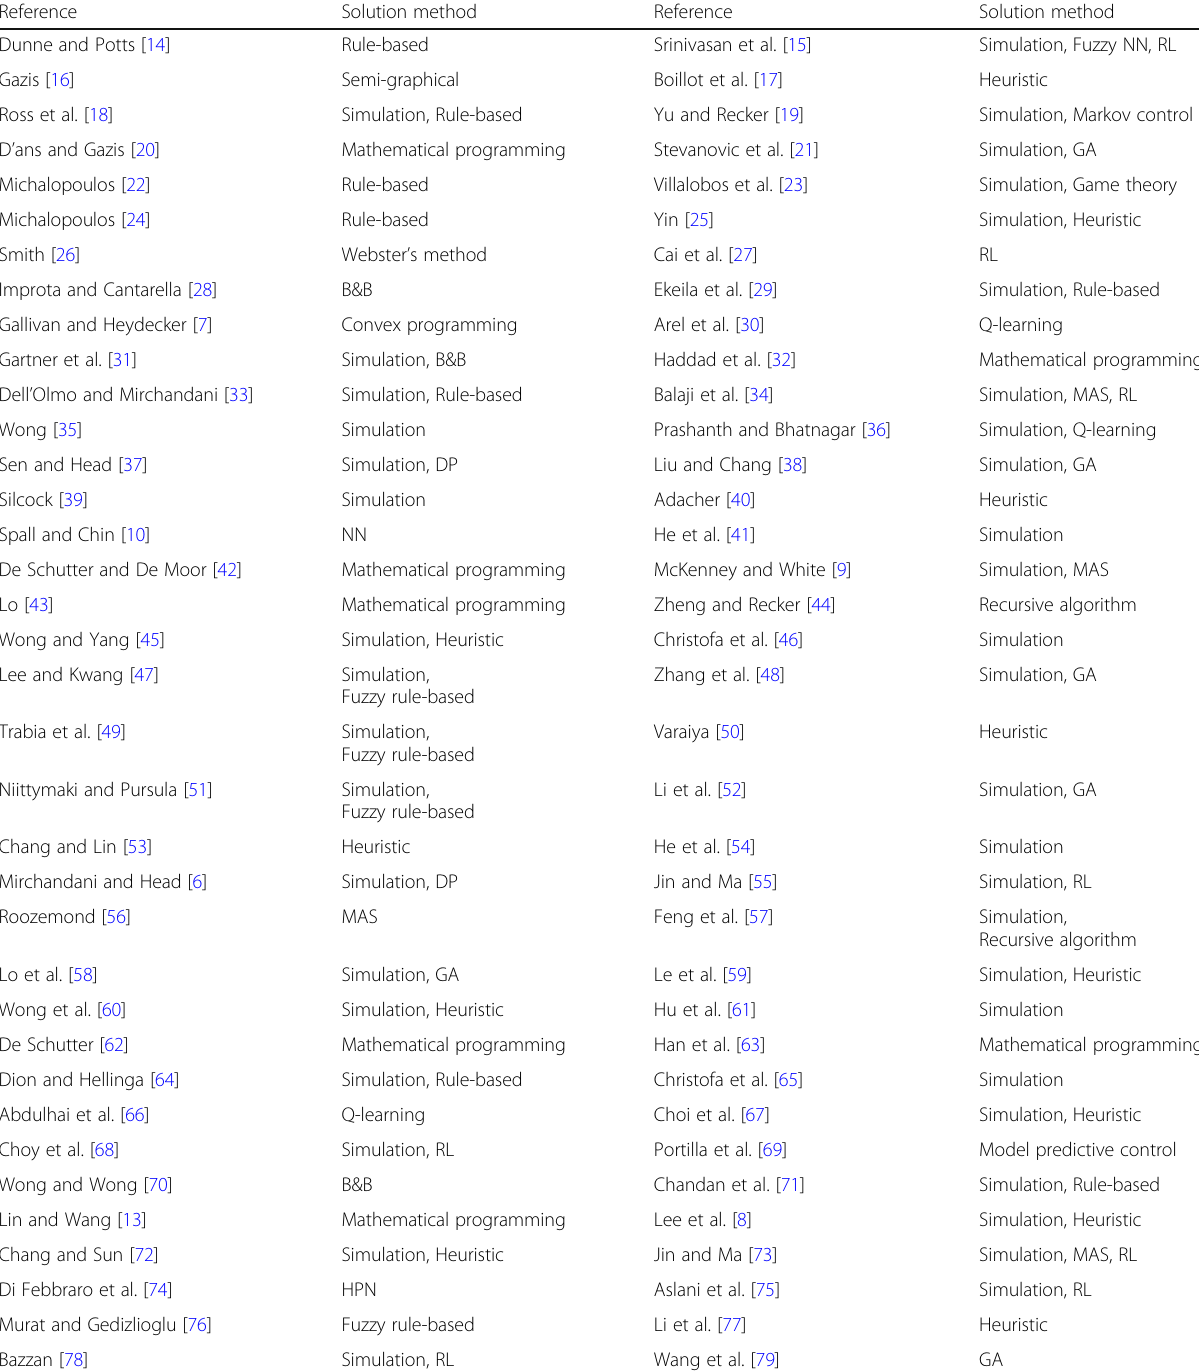
Table 4 Solution methods for